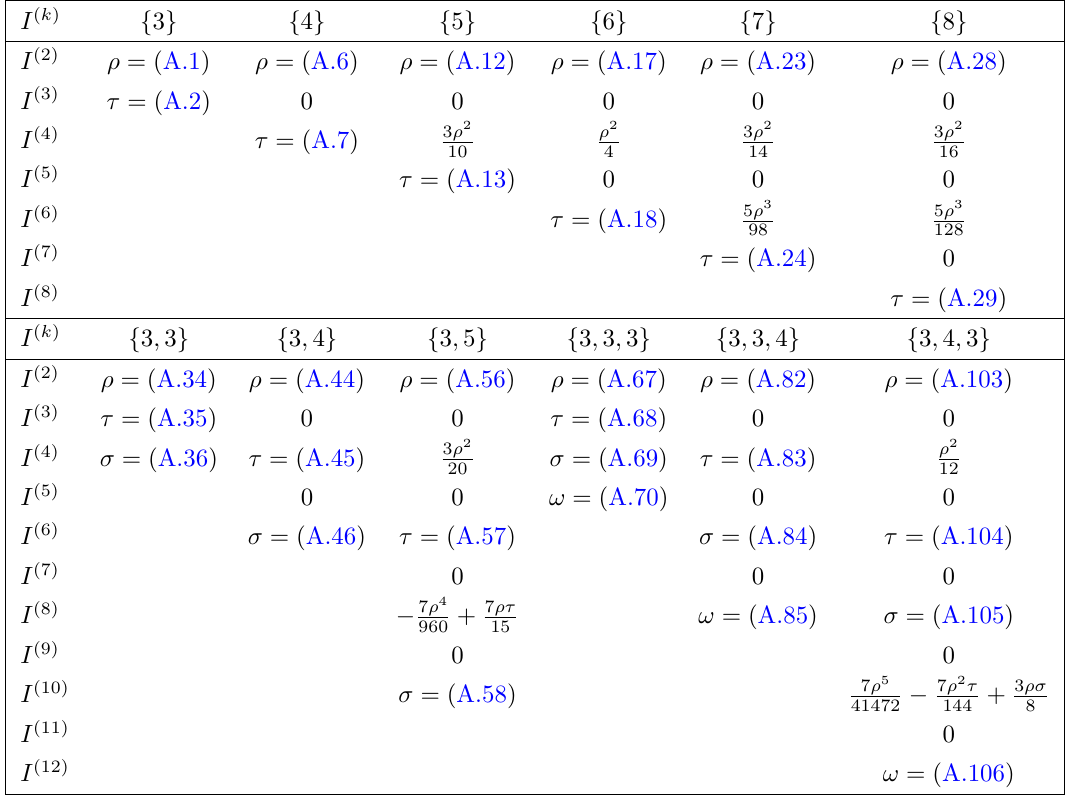
Table 2 . For each polytope P , we give the basic G -invariant polynomials I ( k ) , expressed in terms of the elements of the relative B P , making reference to the corresponding equation in the main